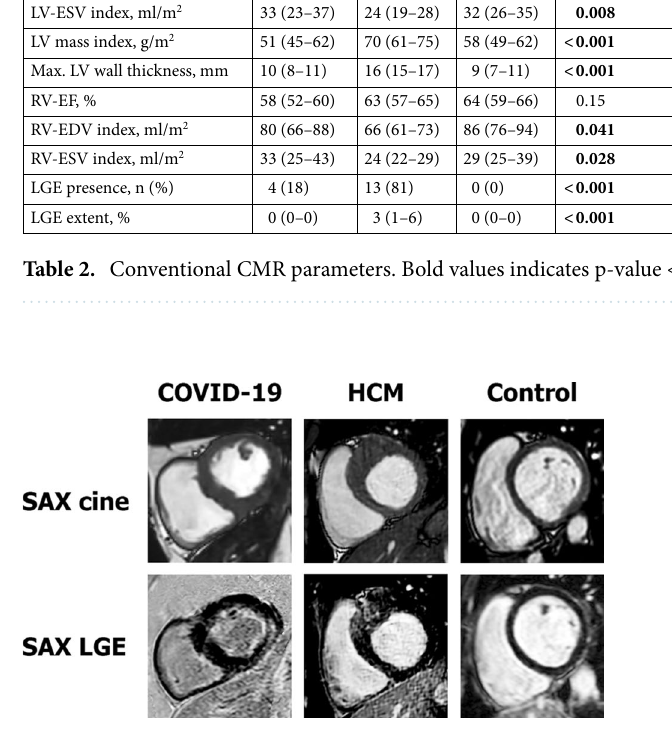
Figure 1. Cardiovascular magnetic resonance (CMR) cine-images (1st row) and late gadolinium enhancement (LGE)-images (2nd row) in short-axis views of patients who recently recovered from coronavirus disease (COVID-19) (1st column), with hypertrophic cardiomyopathy (HCM) (2nd column) and a healthy control (3rd column).